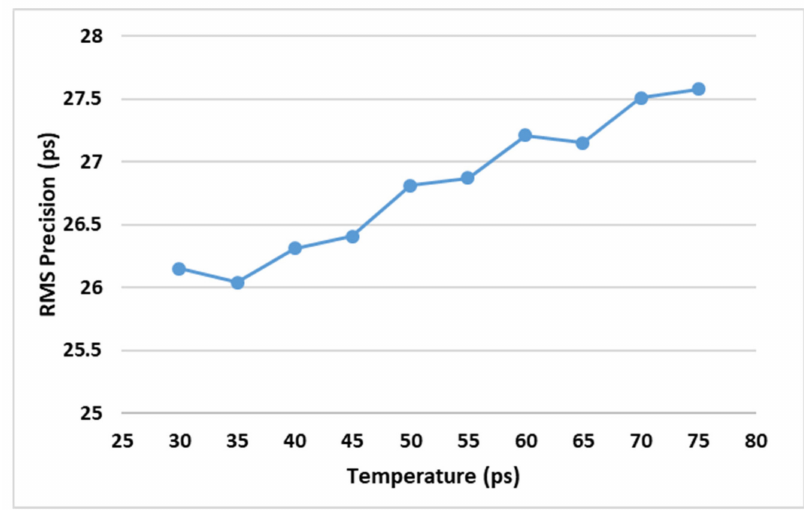
Figure 12. RMS precision variations with temperature.